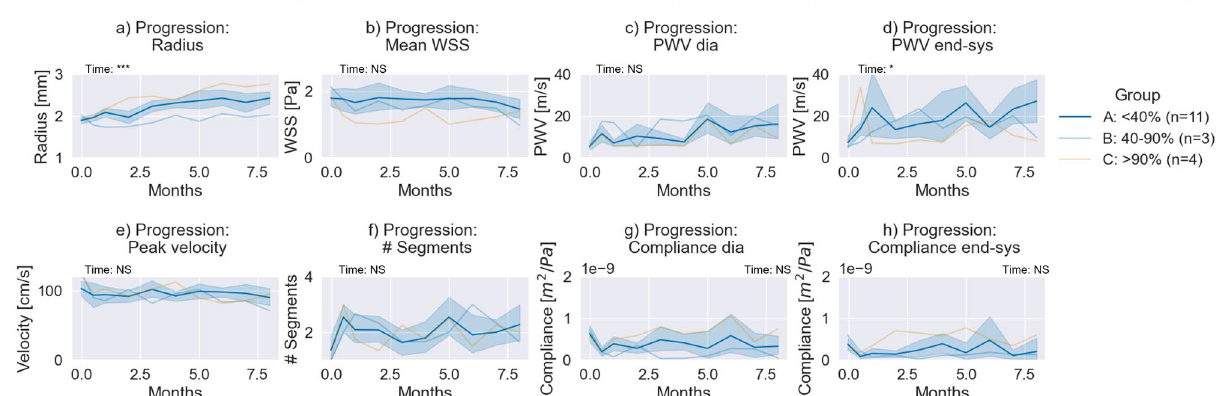
Figure 2. Progression of derived markers for the non-ligated carotids. The stiffness of the vessel, indicated by the compliance ( g , h ) and the PWV ( c , d ) increases over the course of the study, indicating vascular damage. ( a ) The radius of the carotid lumen. ( b ) The estimated temporal-averaged wall shear stress. c , The pulse wave velocity at diastolic (dia) pressure. ( d ) The pulse wave velocity at end-systole (end-sys). ( e ) The peak velocity. ( f ) The number of detected segments. ( g ) The compliance at diastolic (dia) pressure. ( h ) The compliance at end- systole (end-sys). The data are represented as the mean (bold) and the 95% confidence interval (transparent). One-way repeated measures ANOVA was conducted to quantify the significance (*<0.05, **<0.01 and ***< 0.001, with Holm-Sidak